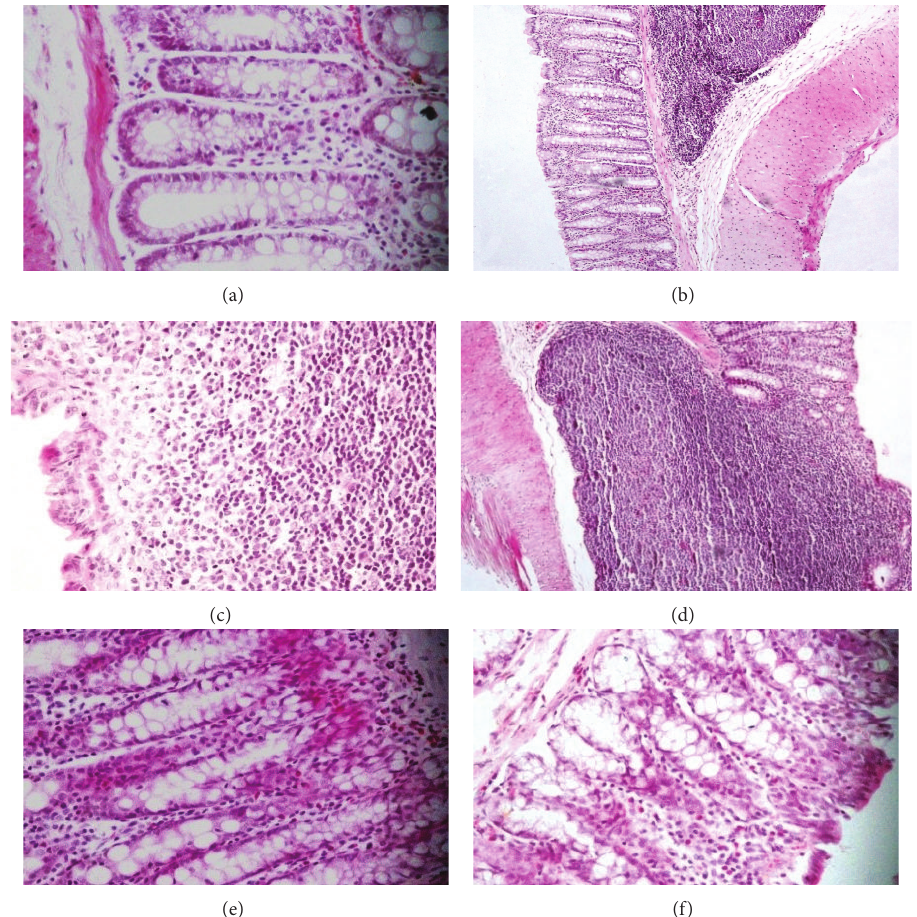
Figure 2: Histopathological findings of colonic tissues from different animals’ groups; (a) colonic tissue for animals treated with OO shows normal surface epithelium and crypt cells × 400. (b) Colonic tissue for animals treated with high dose OZO alone with normal surface epithelium and crypt cells × 200. (c) Inflamed control group; the mucosa shows focal loss of the covering and lamina propria shows dense lymphoplasmacytic and histiocytic infiltrate to the submucosa × 200. (d) Inflamed animals treated with OO; mononuclear granulomatous infiltrate encroaching on the overlying mucosa with apparent destruction of the muscularis mucosa and mucosal covering × 200. (e) Inflamed animals treated with low dose OZO nearly normal mucosa and submucosa with polypoid formation. Crypt cell hyperplasia and elongation. Lamina propria is infiltrated by monocytes and eosinophils 400x. (f) Inflamed animals treated with high dose OZO, showing normal mucosal lining and submucosa and cellular infiltrate with eosinophils 200x. Table 2: Macro and microscopic damage scores for the animal